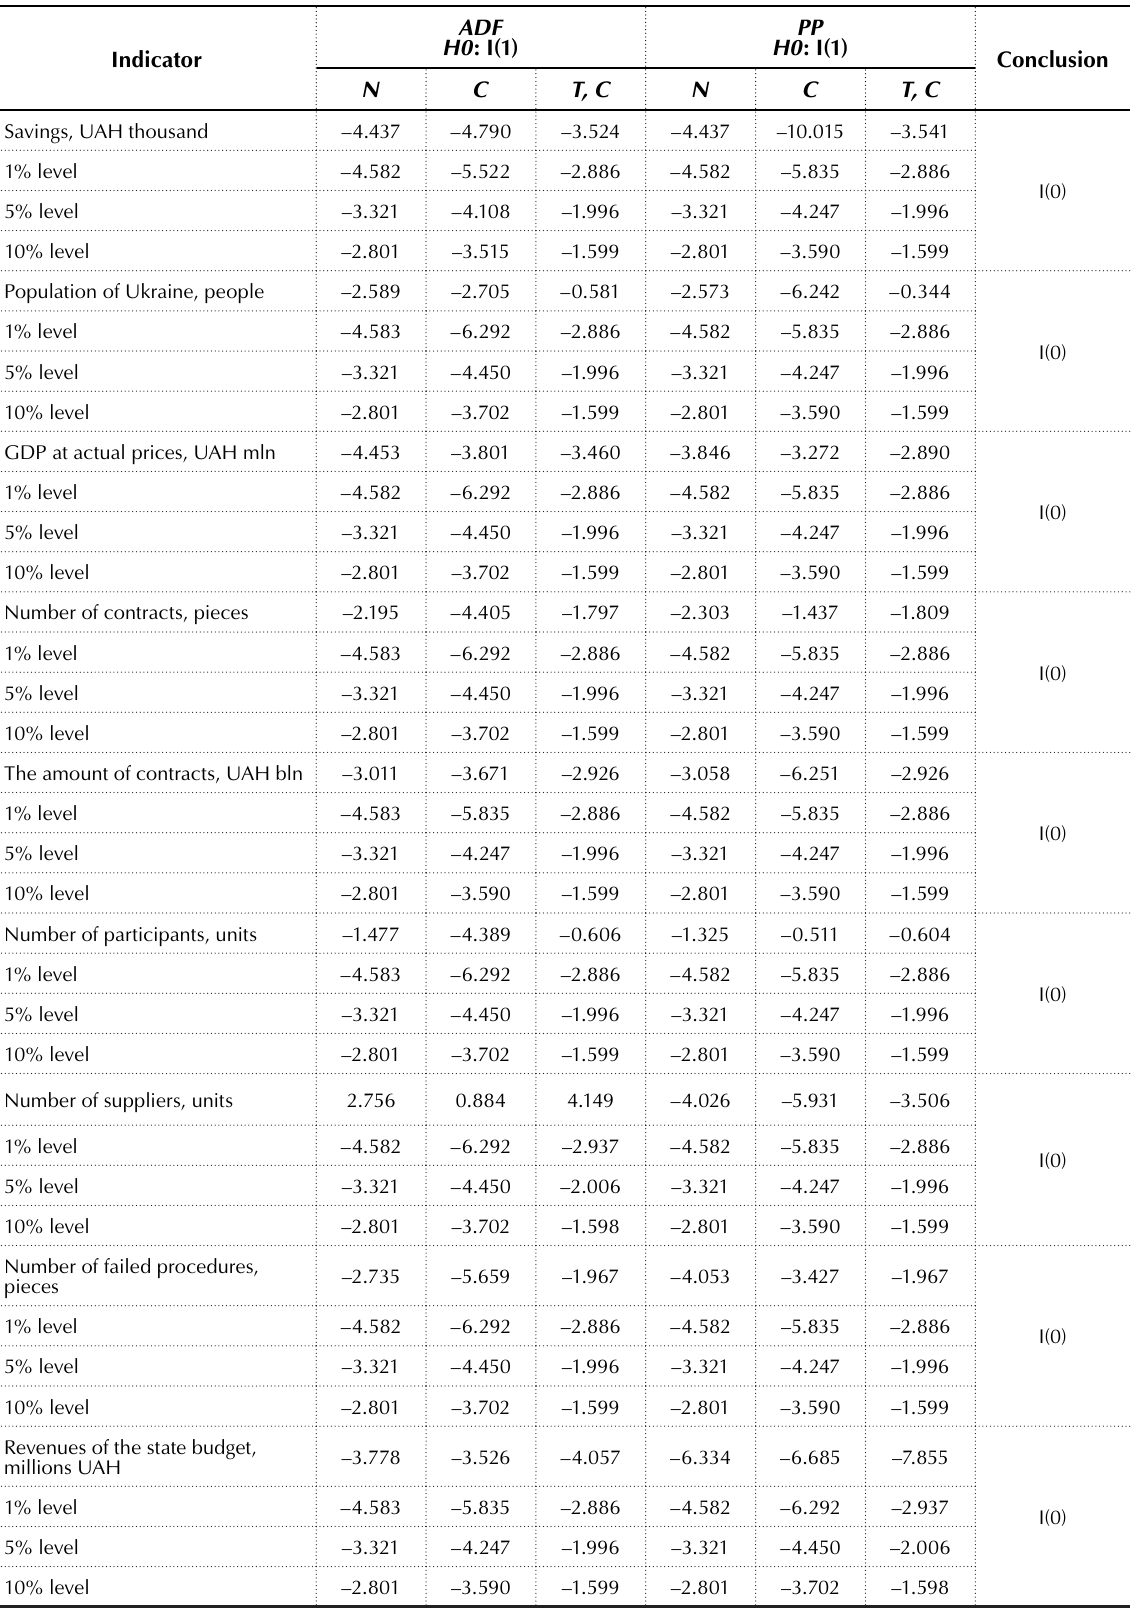
Table 4. Results of the stationary study of the first differences in the indicators of savings in the public procurement system and the factors that may affect